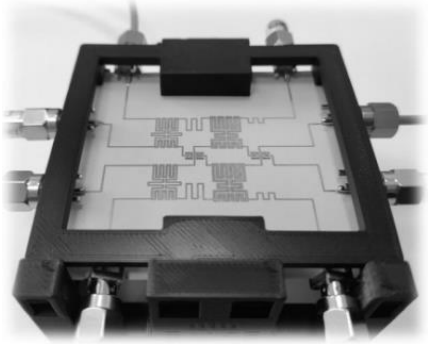
Figure 14. BM of Section 4.2: photograph of the fabricated prototype.